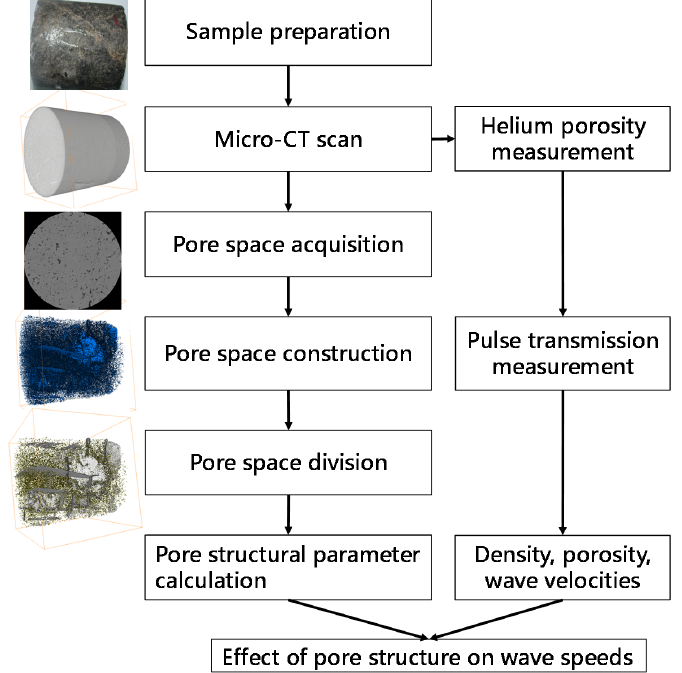
Figure 4. Workflow chat for characterizing the pore space and analyzing its effect on wave speeds. After sawing the samples into cylindrical plugs, the samples are scanned using micro-CT. Then, the